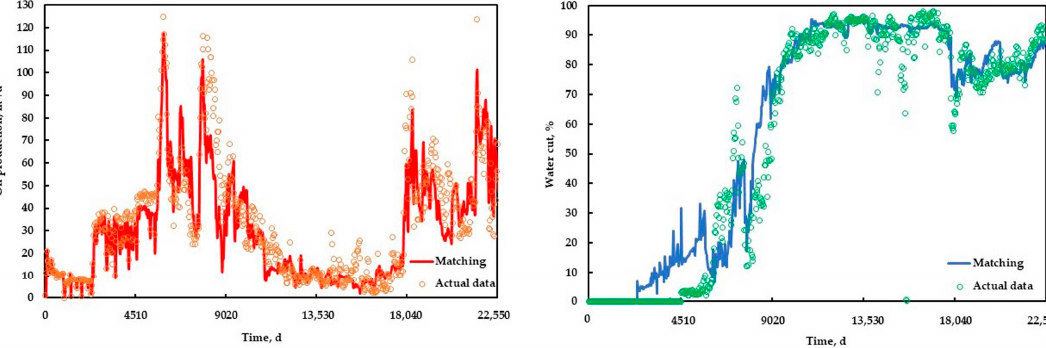
Figure 13. The history matching results of the reservoir.